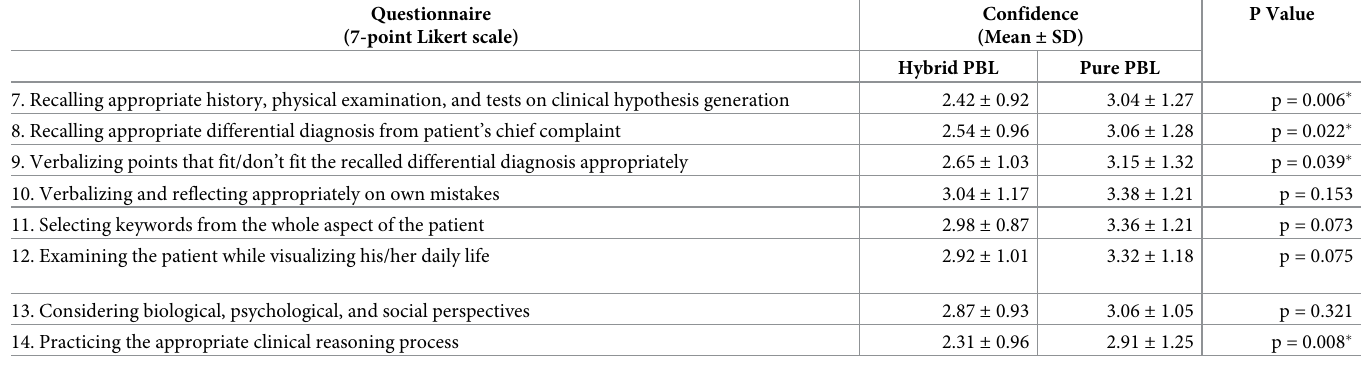
Table 4. Baseline of fifth-year medical students’ self-evaluation of competency in clinical reasoning before the educational intervention, based on the 7-point Likert scale about hybrid- and pure-PBL, Chiba University Hospital (N = 99). Questionnaire (7-point Likert scale)